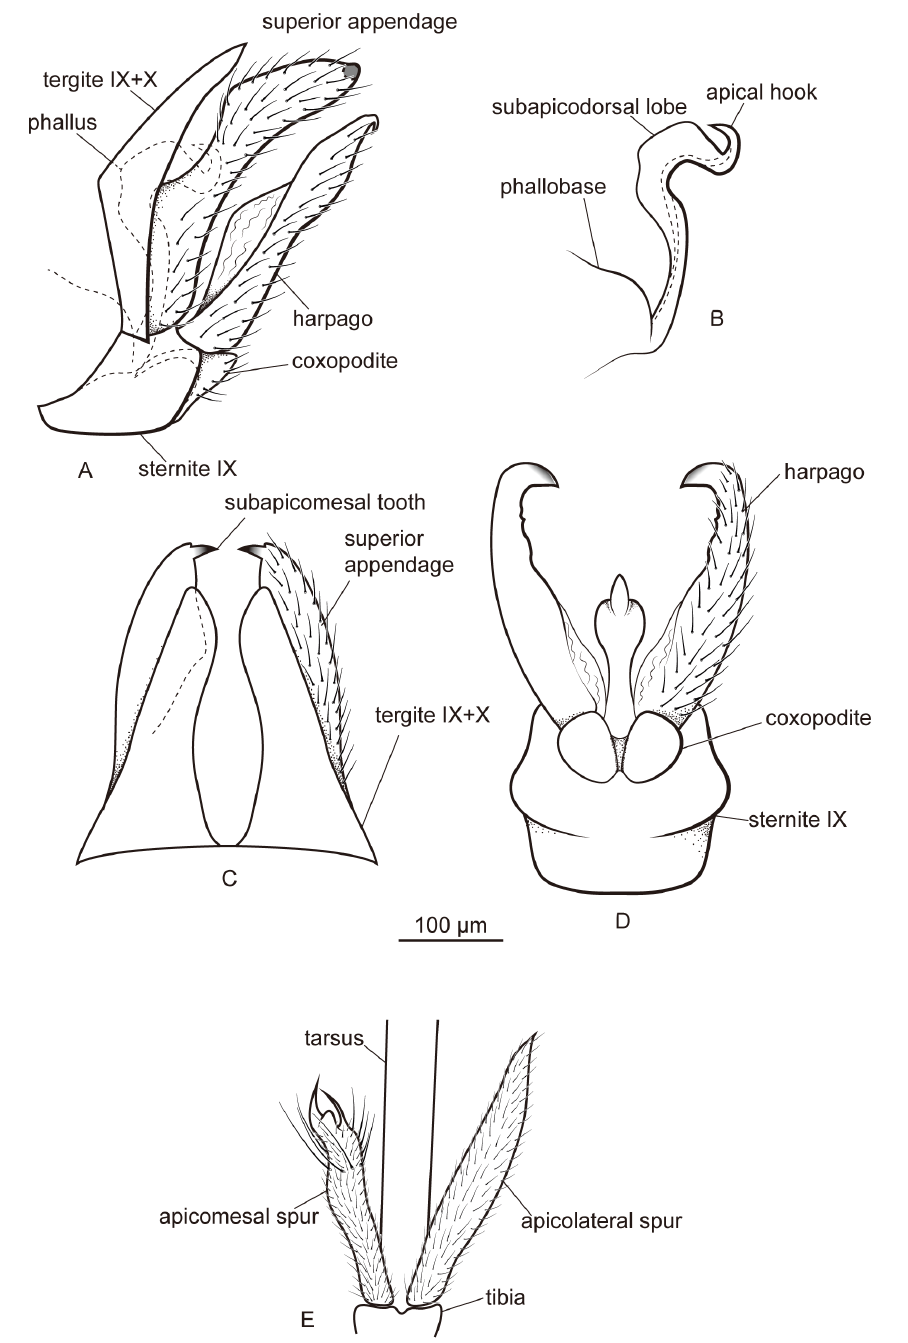
Figure 5. Male of Metalype uncatissima (Botosaneanu, 1970). A genitalia, left lateral B phallus, left lateral C genitalia, dorsal D genitalia, ventral E apical spurs of right hind leg,